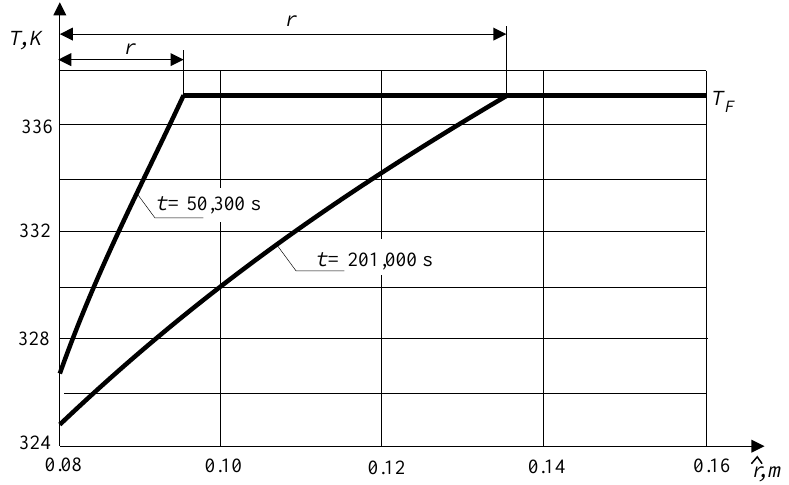
Figure 6. Temperature distribution in the solidified layer for RT64HC ( B = 0, Bi CON = 10, Bi C = 177, s = 0.5 ).